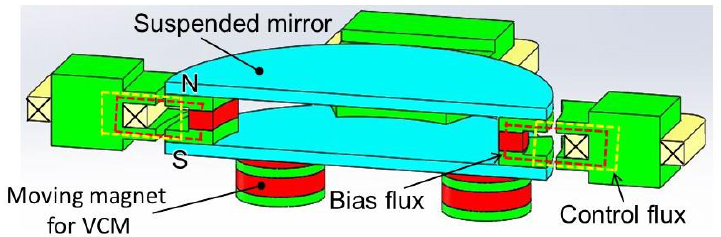
Figure 4. The proposed magnetic suspension mechanism. The lateral movement is controlled by electromagnets. The other motion is supported by the magnetic coupling.